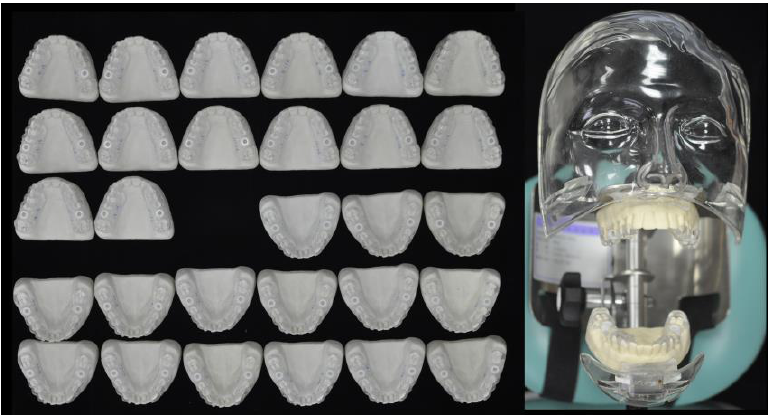
Figure 1. Simulated clinical position and the guided stents on epoxy tooling board model.